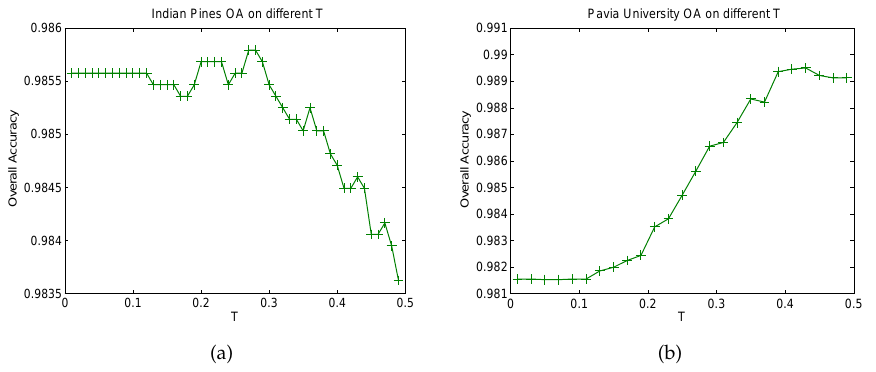
Figure 3. Overall classification accuracies for different values of T. ( a , b ) show the OA versus different values of T on the Indian Pines and Pavia University datasets, respectively.